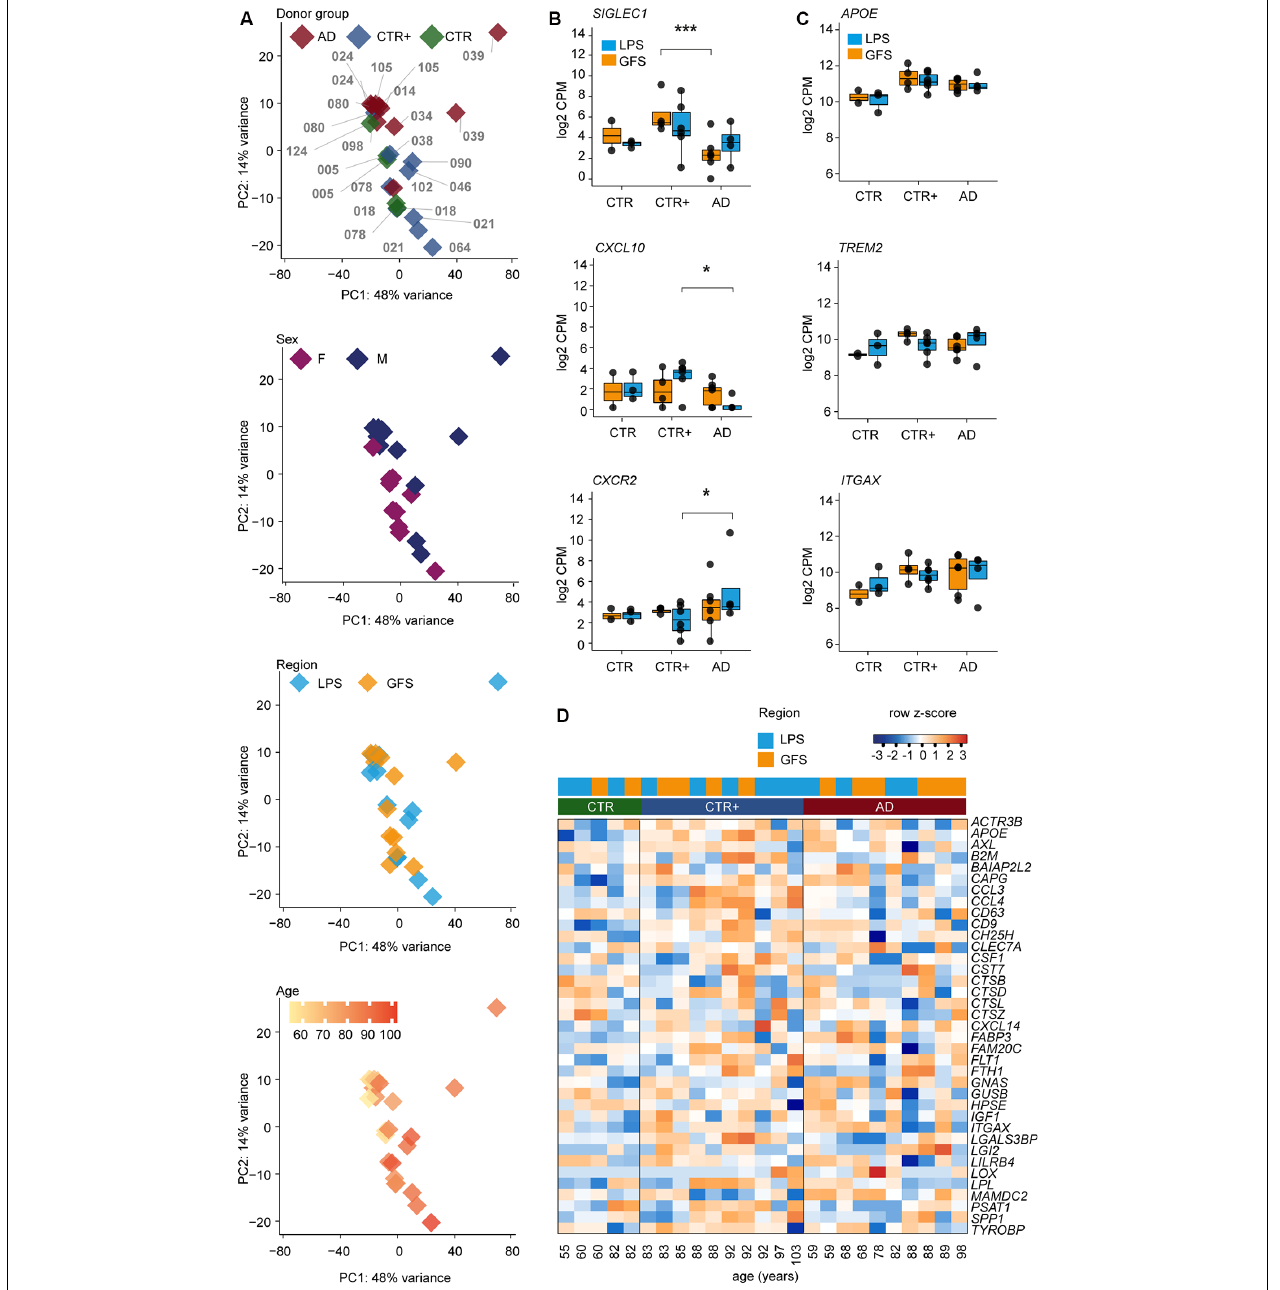
FIGURE 2 | Transcriptomic analysis of microglia populations isolated from CTR, CTR+, and AD donors. (A) Principal component analysis (PCA) of RNA-sequencing data from acutely isolated microglia illustrating the effect of donor (each sample is indicated with a donor label), donor groups, sex, brain region, and age. (B) Differentially expressed genes between AD and CTR+ donors (likelihood ratio test, SIGLEC1 ***FDR = 0.002, CXCL10 *FDR = 0.02 and CXCR2 ∗ FDR = 0.02). (C) Selected examples of expression levels (log 2 CPM) of disease-associated microglia genes in bulk microglia samples. (D) Heat map depicting expression of most abundant disease-associated microglia genes in bulk microglia samples from three donor groups in row z scores of log 2 CPM values. Donors are ordered by age (young to old) within the donor group. Abbreviations: AD, Alzheimer’s Disease; CPM, counts per million; CTR, Control; CTR+, Control with A β plaques and/or hyperphosphorylated tau; F, female; M, male; GFS, superior frontal gyrus; LPS, superior parietal lobe.